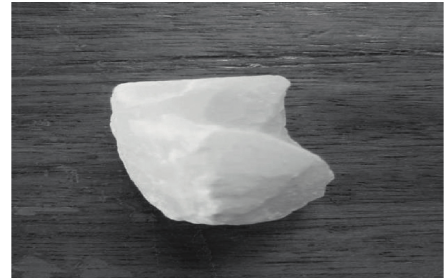
Figure 1: A sample of local kaolin obtained